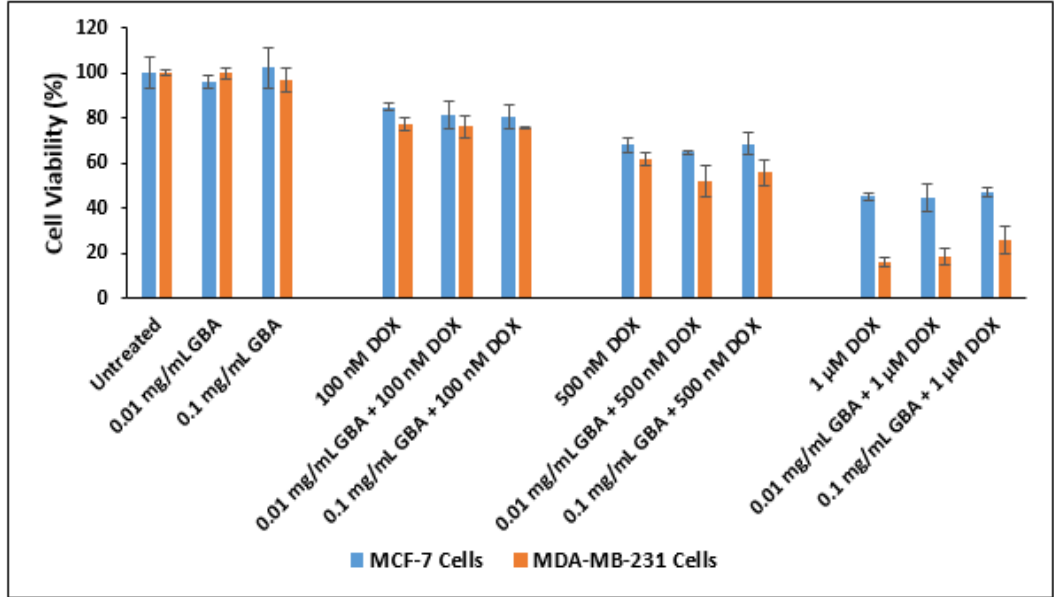
Figure 10. Effect of DOX-loaded GBA on cell viability based on MTT assay after 48 h of treatment in MCF-7 and MDA-MB-231 cells. Approximately 50,000 cells were seeded per well in 24 well plates. Cells were treated after 24 h with (DOX) doxorubicin (100 nM, 500 nM or 1 µM) in free form and in complexation with GBA at 0.01 mg / mL or 0.1 mg / mL. Cell viability was calculated using the absorbance of untreated cells as 100%. Table 5. Cytotoxicity enhancement of DOX-loaded GBA in MCF-7 and MDA-MB-231 cells. GBA Containing Different Concentrations of DOX